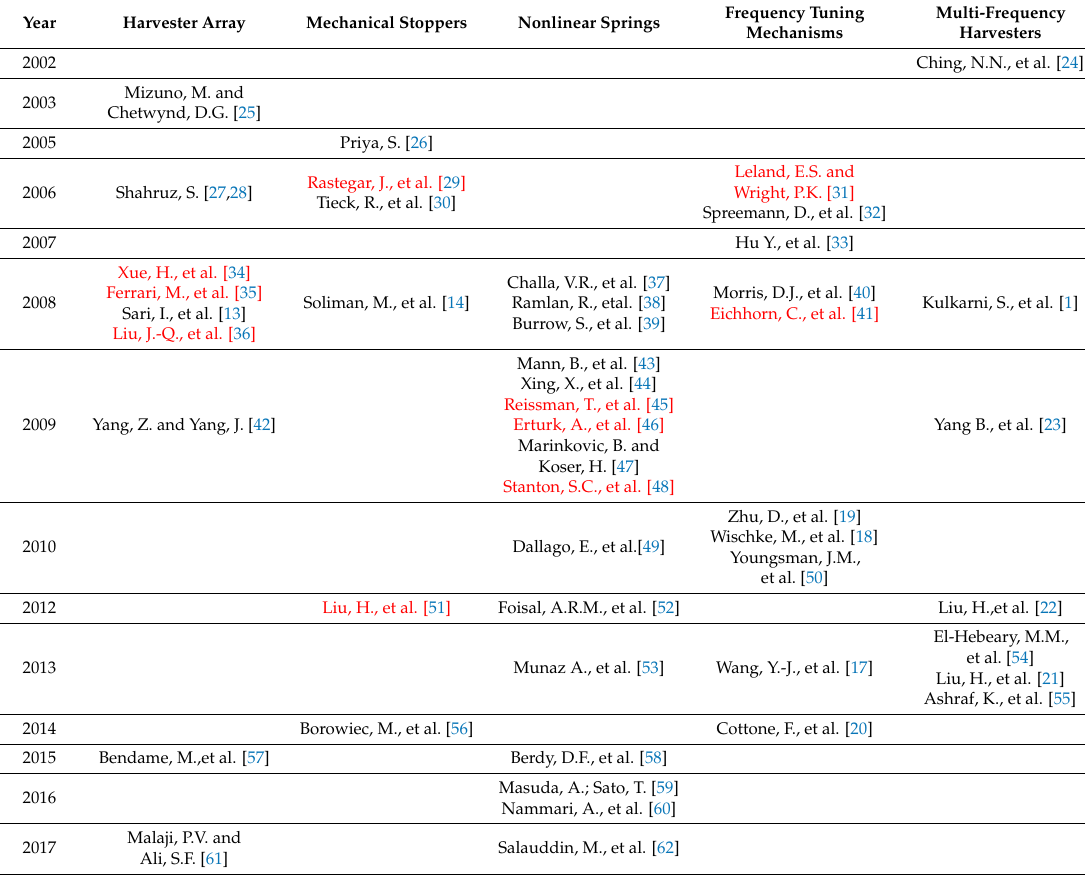
Table 1. Relevant literature for five different